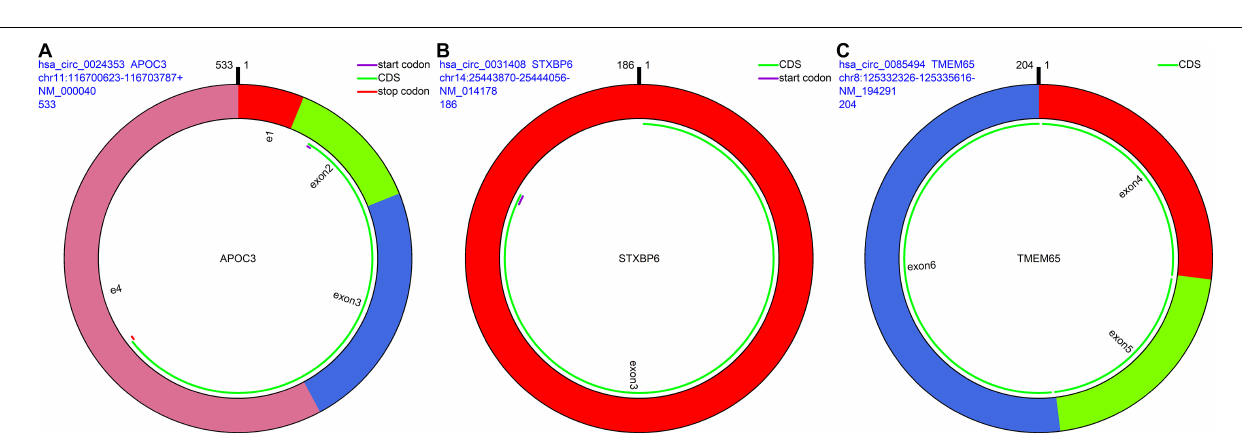
FIGURE 3 | CircRNA annotation. The start codon, coding sequence, stop codon, parental gene symbol, position, and length are all presented in pattern graphs. (A) hsa_circ_0024353 is formed by the circularization of exon 2 and exon 3 of the APOC3 gene. (B) hsa_circ_0031408 is formed by the circularization of exon 3 of the STXBP6 gene. (C) hsa_circ_0085494 is formed by the circularization of exons 4–6 of the TMEM65